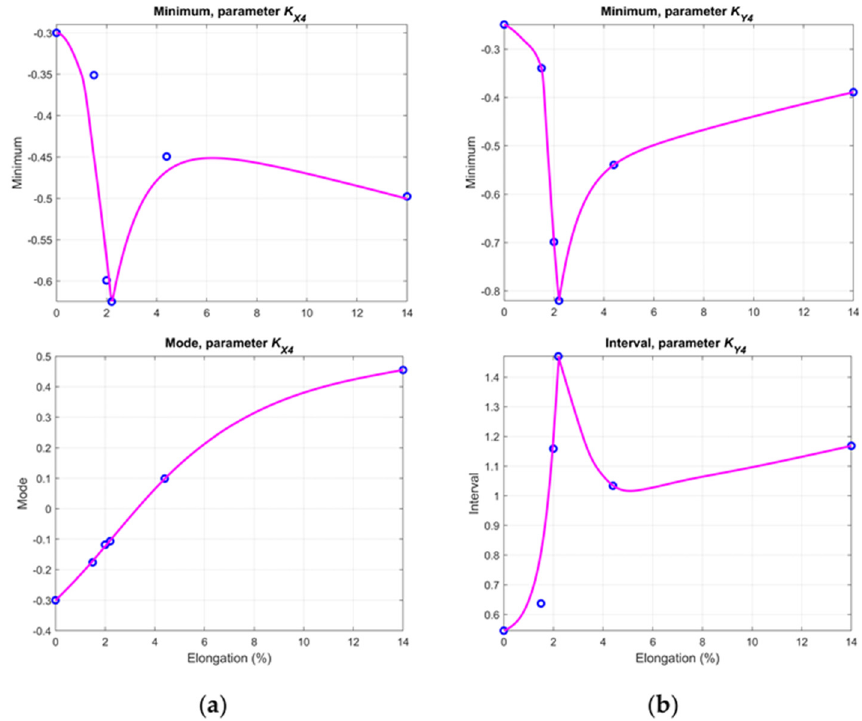
Figure 10. Chosen statistical values of the K A 4 parameter for the: ( a ) x -axis direction; and ( b ) y -axis direction.